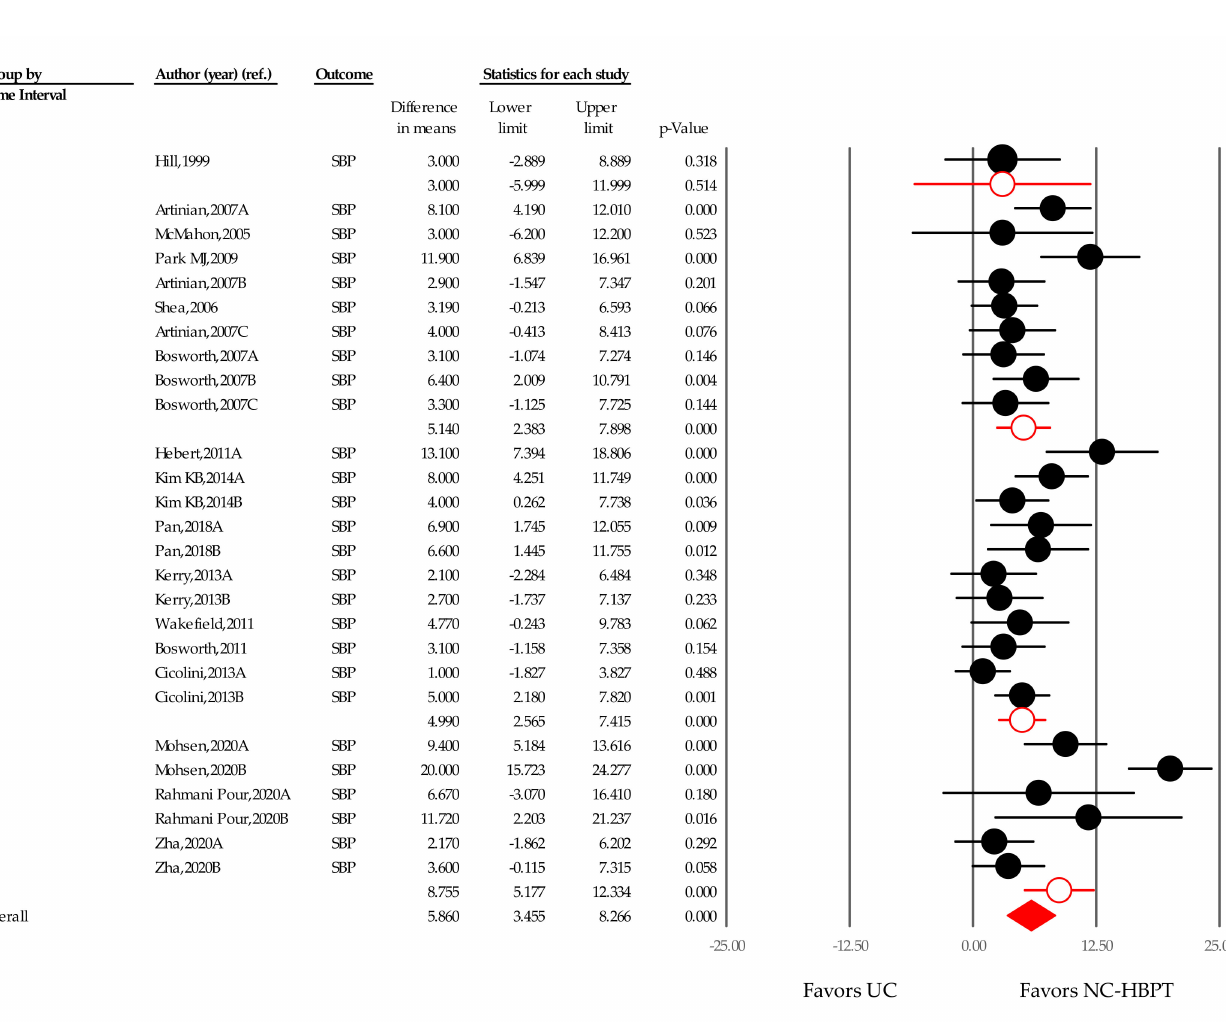
Figure 6. Difference in means of office systolic blood pressure changes over time. Notes. Point estimate of individual study ( ● ); Subgroup ( ○ ); Summary effect size ( ◆ ); DBP, diastolic blood pressure; UC, usual care; NC-HBPT, nurse-coordinated home blood pressure telemonitoring.